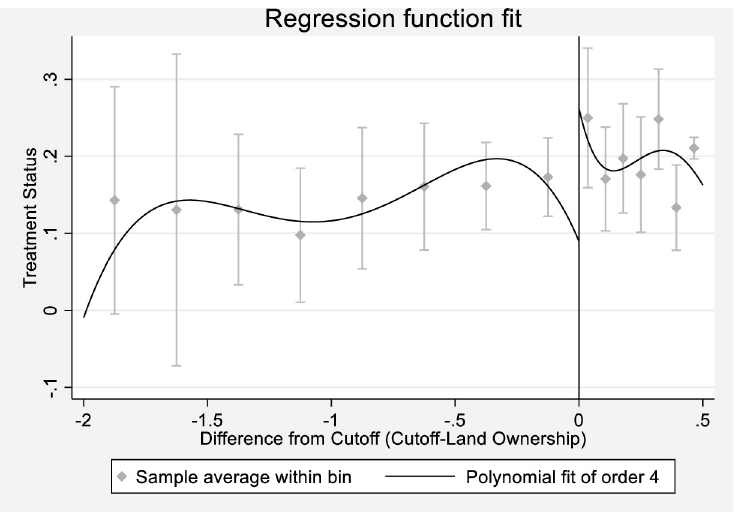
Fig 1. Discontinuity in treatment status around the cutoff. Notes : The horizontal axis is the difference from the cutoff in acres, and the vertical axis shows the treatment dummy. Every dot in the graph represents the sample average within bin, whereas every line represents the fourth order polynomial approximation of the outcome variable. The vertical line in the figure indicates 0 acres from the cut-off.